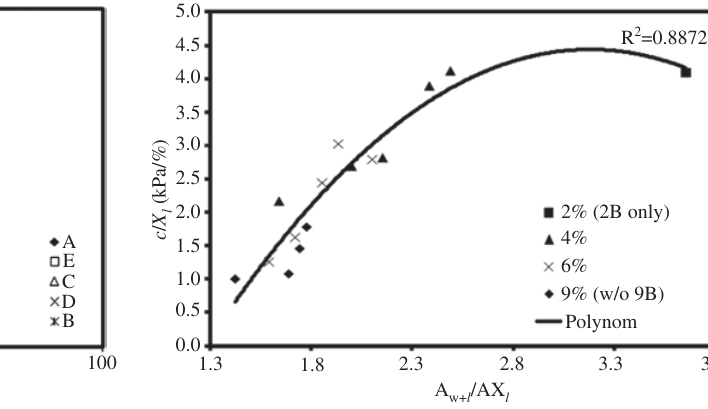
Figure 10 Normalized cohesion versus normalized area ratio (selected